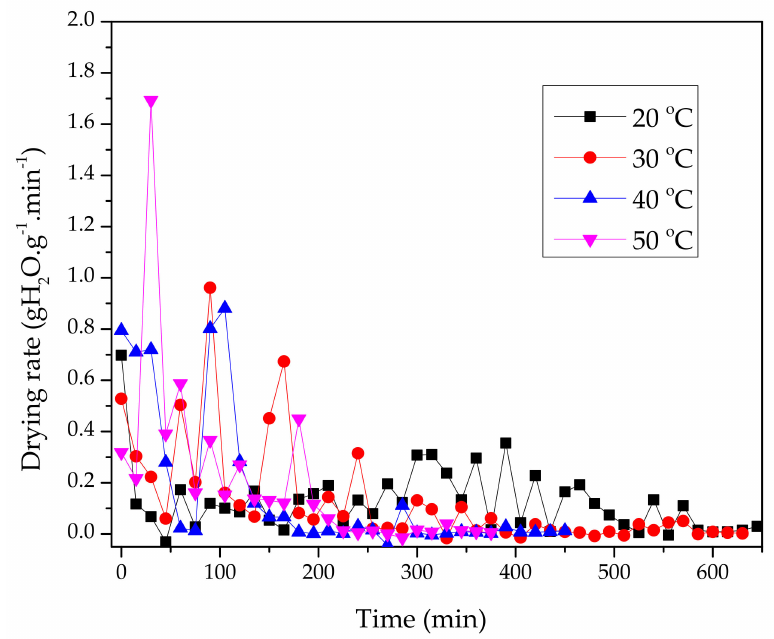
Figure 3. Variation of drying rate over time at different temperatures ( p <